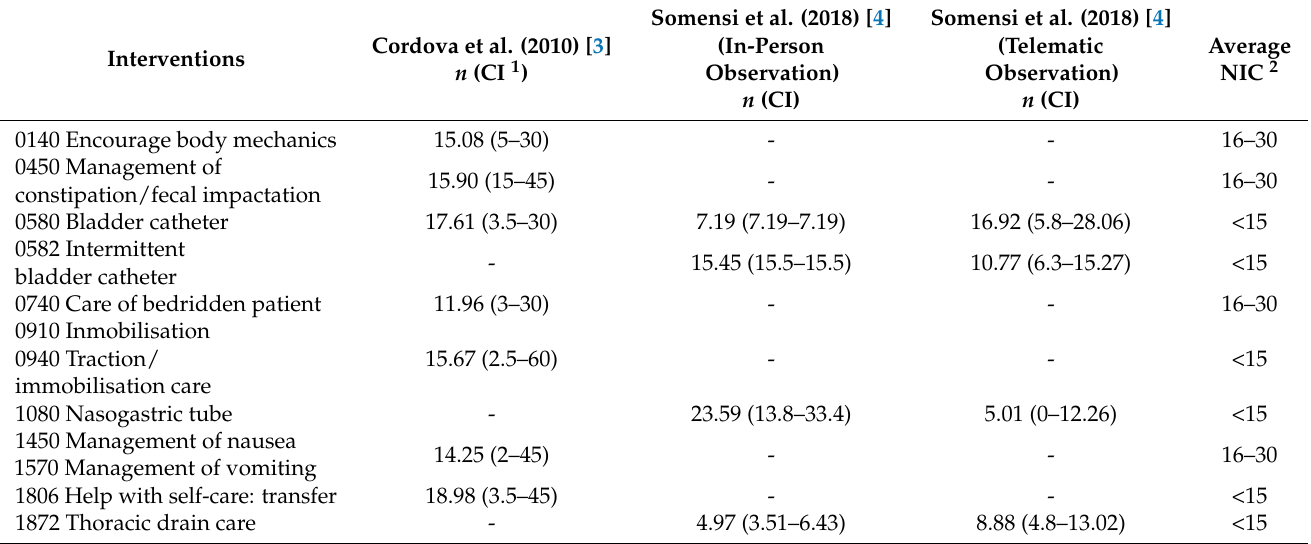
Table 5. Average time observed in the studies and NIC averages in minutes in numerical or alphabet- ical